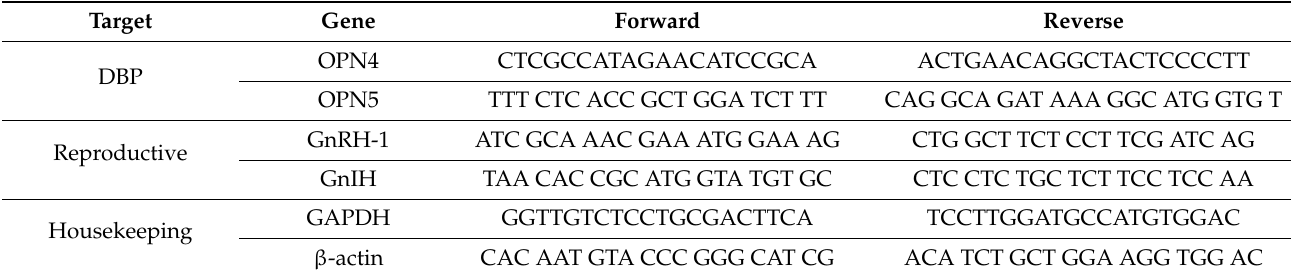
Table 1. qRT-PCR primer